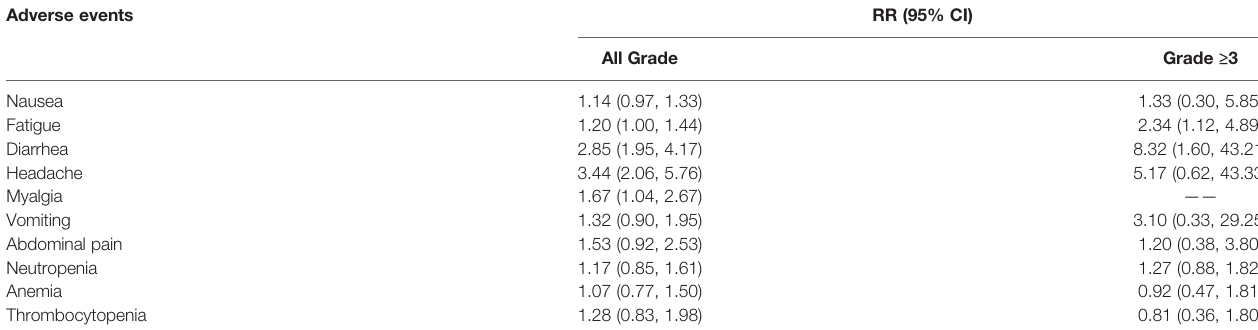
TABLE 2 | Common treatment-related adverse events in this meta-analysis. Adverse events RR (95% CI)